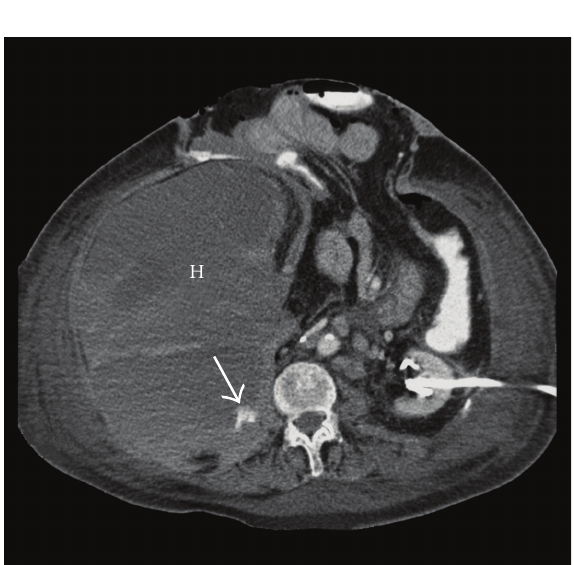
Figure 1: CT angiography demonstrating a large retroperitoneal hematoma (H) with evident mass e ff ect and contrast extravasation